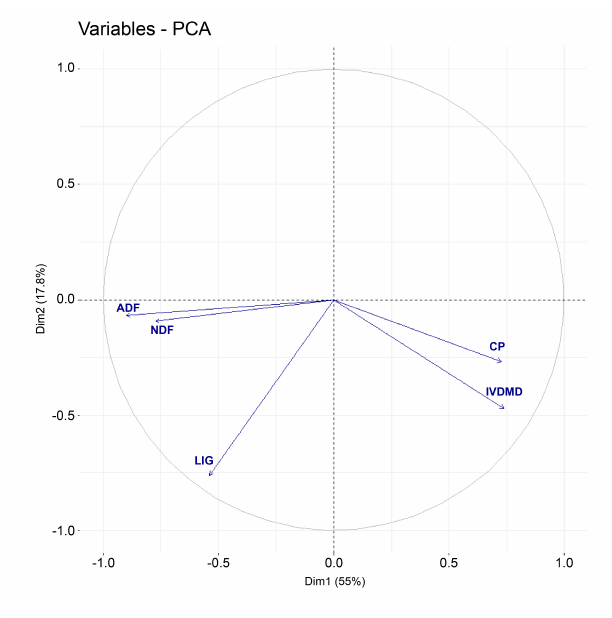
Figure 1. Correlation circle illustrating the direction and intensity of the five forage quality variables used in the principal component analysis. CP, Crude Protein; IVDMD, In Vitro Dry Matter Digestibility; NDF, Neutral Detergent Fibre; ADF, Acid Detergent Fibre; LIG,